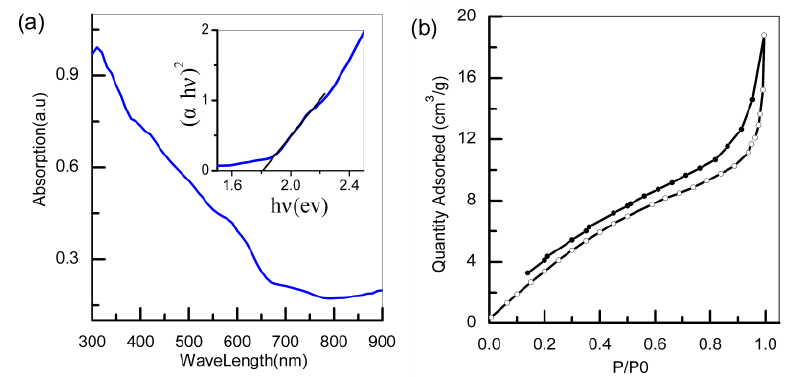
Figure 4. UV-vis absorption spectra ( a ); N2 adsorption–desorption isotherms ( b ) of CuBi 2 O 4 nanofibers.